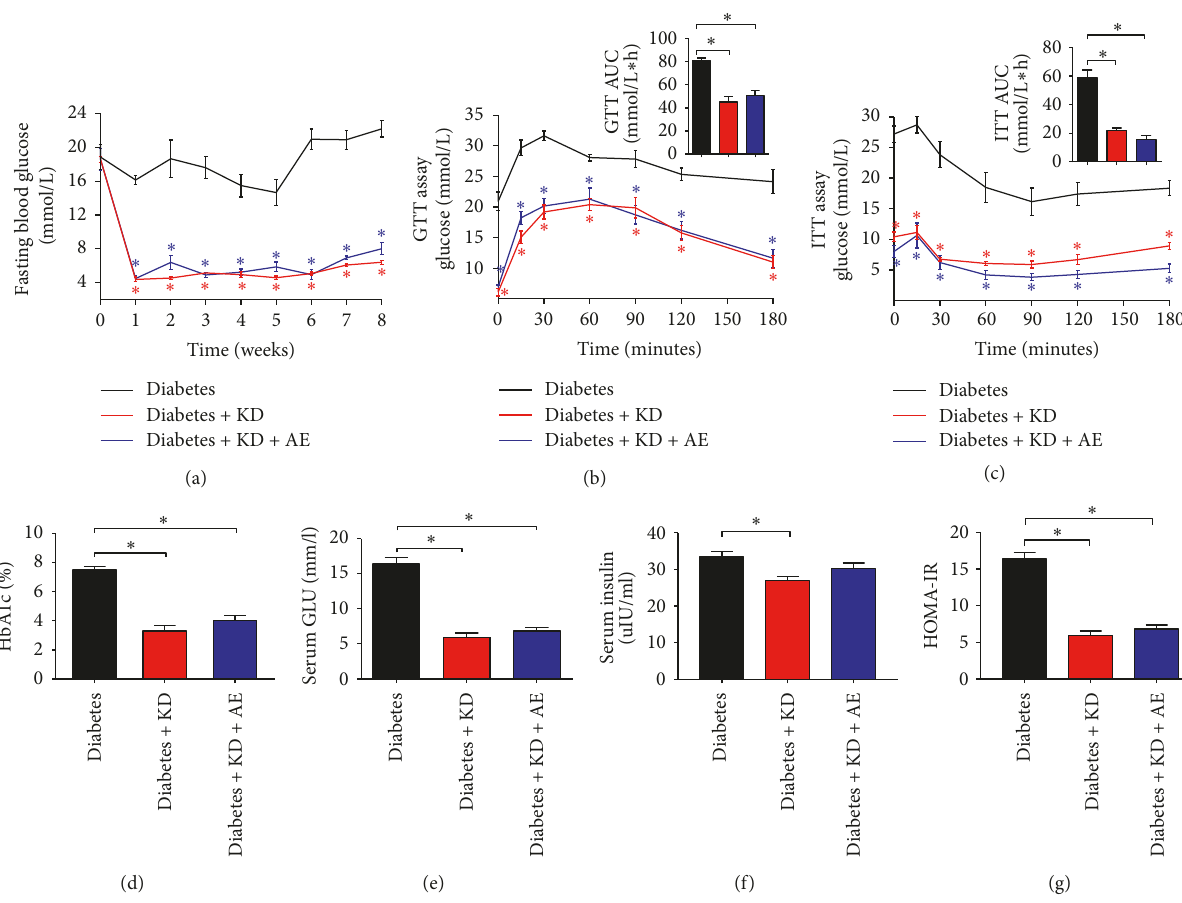
Figure 2: Ketogenic diet and ketogenic diet combined with exercise improve insulin sensitivity in diabetic mice. (a) Mice fasting blood glucose, (b) GTT, (C) ITT, (d) HbA1c levels, (e) serum glucose, (f) insulin levels, and (g) HOMA-IR indexes in the diabetes, diabetes + KD, and diabetes + KD + AE groups, after 6-week intervention. Data were presented as means ± SEM ( 𝑛 = 6 per group) and statistical analysis was performed with 1-way ANOVA. ∗ 𝑃 < 0.05 versus diabetic